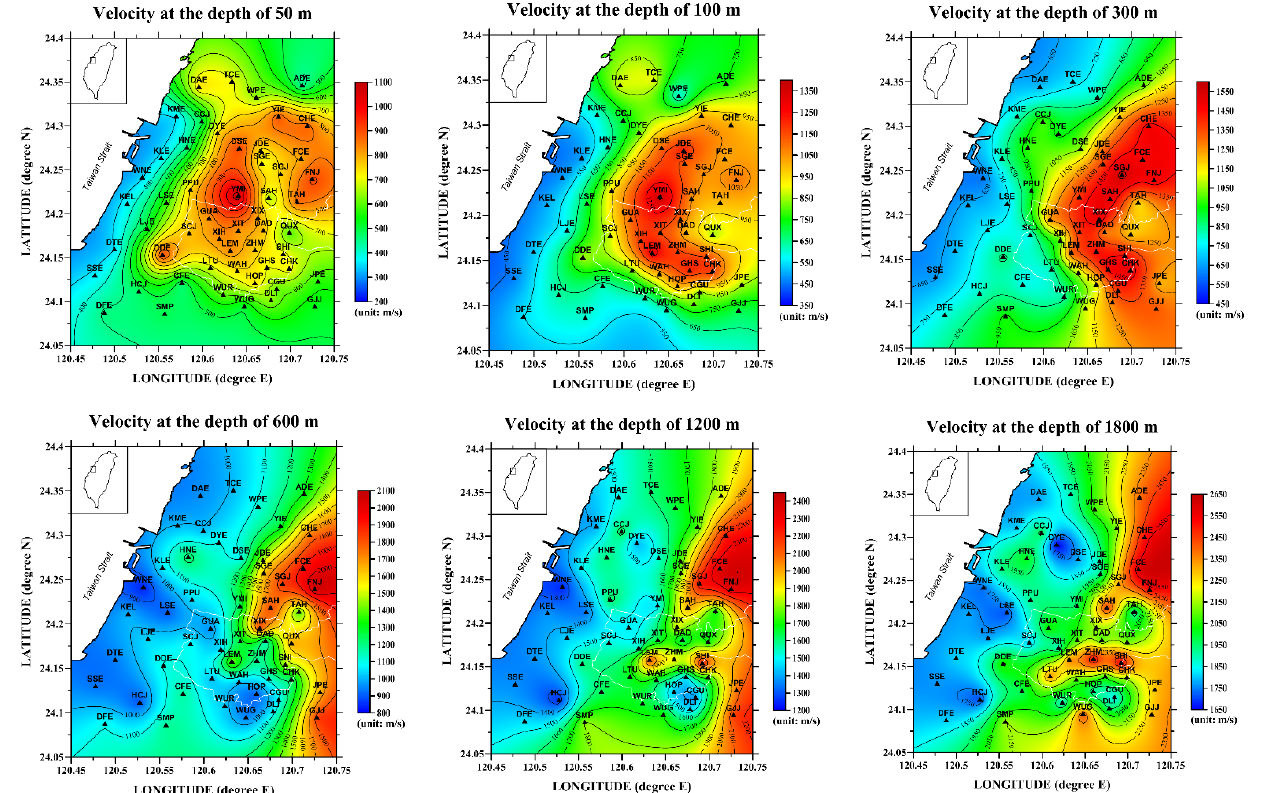
Figure 11. Contour maps of the S-wave velocity variations at six selected depths between 50 and 1800 m in the Taichung area.